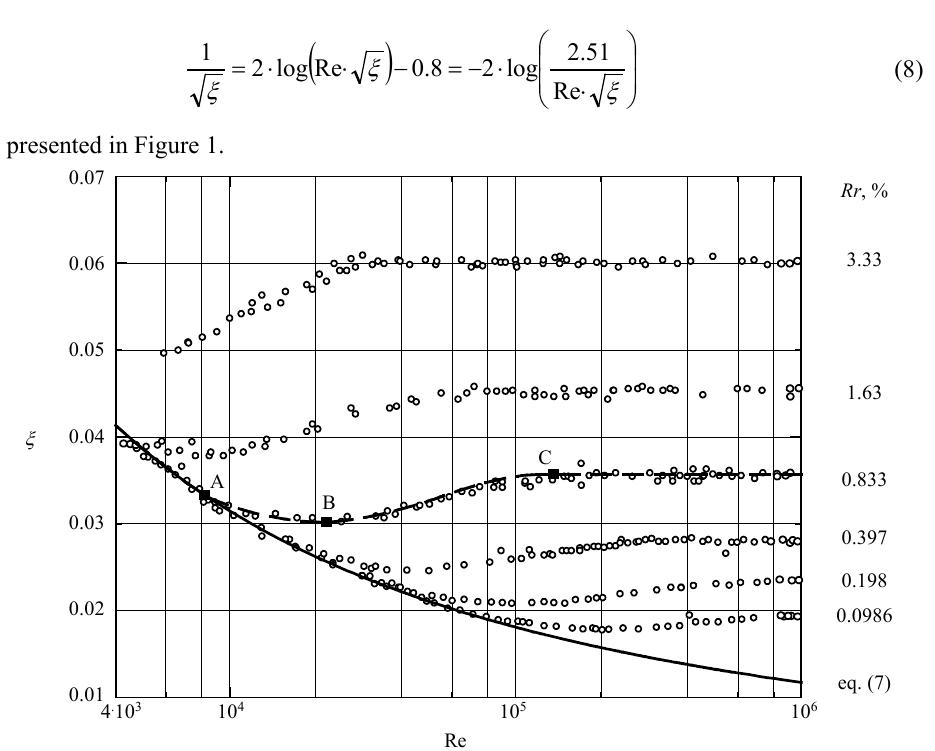
Figure 1 Prandtl’s universal law of friction (8) and Nikuradse’s